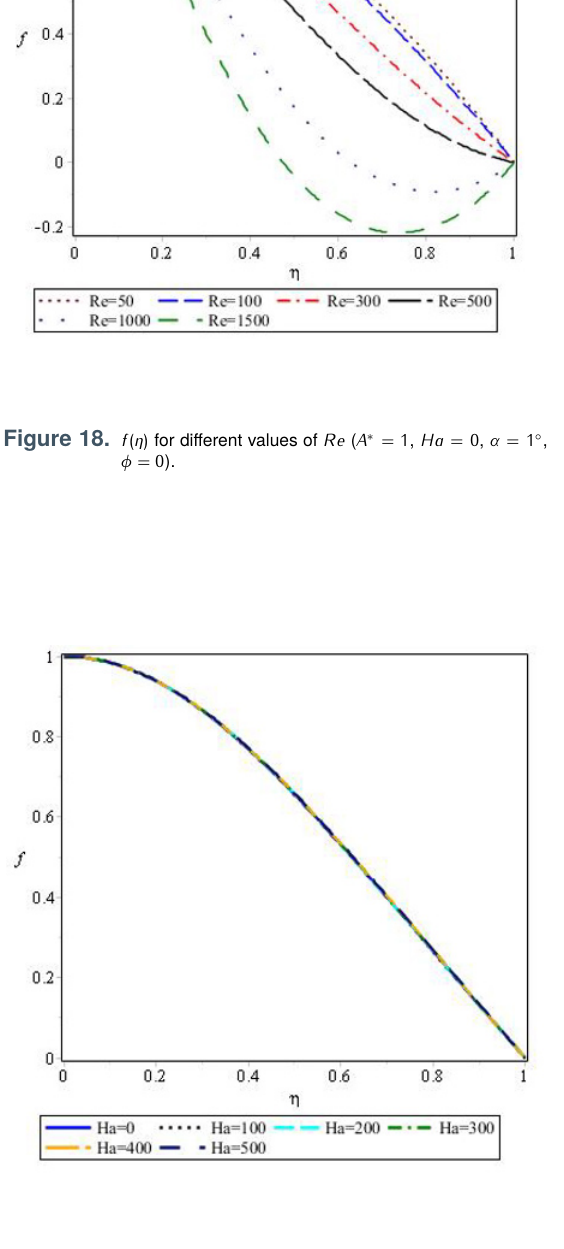
Figure 21. f ( η ) for different values of α ( A ∗ = 1 , Re = 200 , Ha = 0 , φ = 0